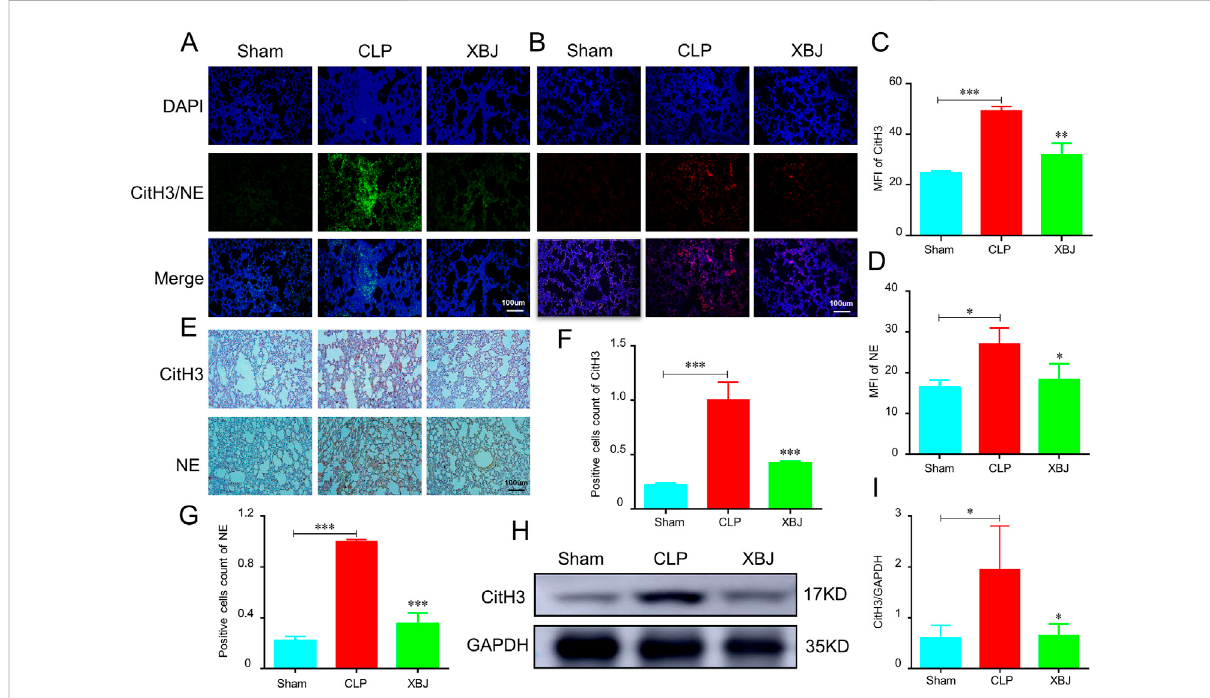
FIGURE 4 XBJ alleviated the NETs formation in the lungs of septic mice (A – D) . Immuno fl uorescent staining was performed on lung sections from CLP mice ( n = 3) and analyzed by confocal microscopy. DAPI (blue), NE (Neutrophil elastase, red) and CitH3 (Citrulline histone 3, green) (A,C) . The expression of CitH3 in lung tissues of indicated groups of mice. The expression of NE in lung tissues of different groups of mice was shown in (B,D – G) .TheexpressionofNETsformationmarkers,CitH3andNE,weredeterminedbyimmunohistochemistryinthelungsectionsofdifferent groups of mice (F,G) . The quanti fi cations of CitH3 (F) and NE (G) expression levels in immunohistochemistry assays ( n = 3) (H,I) . Western blot was performed to determine the expression of CitH3 in the lung tissue of indicated groups of mice. I showed the quanti fi cation of CitH3 expression. N = 4/per group. The values were indicated as mean ± SD. * p < 0.05, ** p < 0.01, *** p < 0.001, compared with the CLP